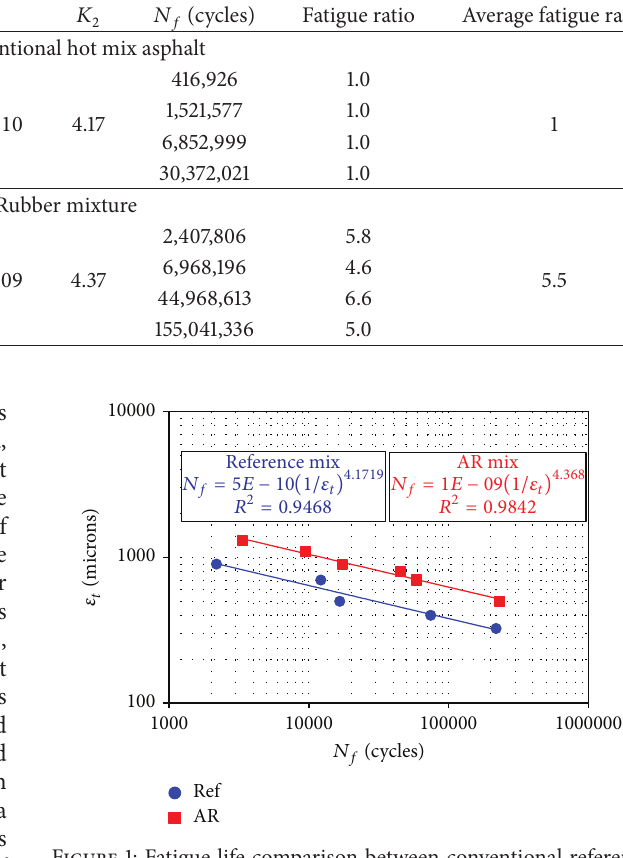
Figure 1: Fatigue life comparison between conventional reference conventional mixture and AR mixture at 21 ∘ C using 𝑁 𝑓 at 50% of the initial stiffness